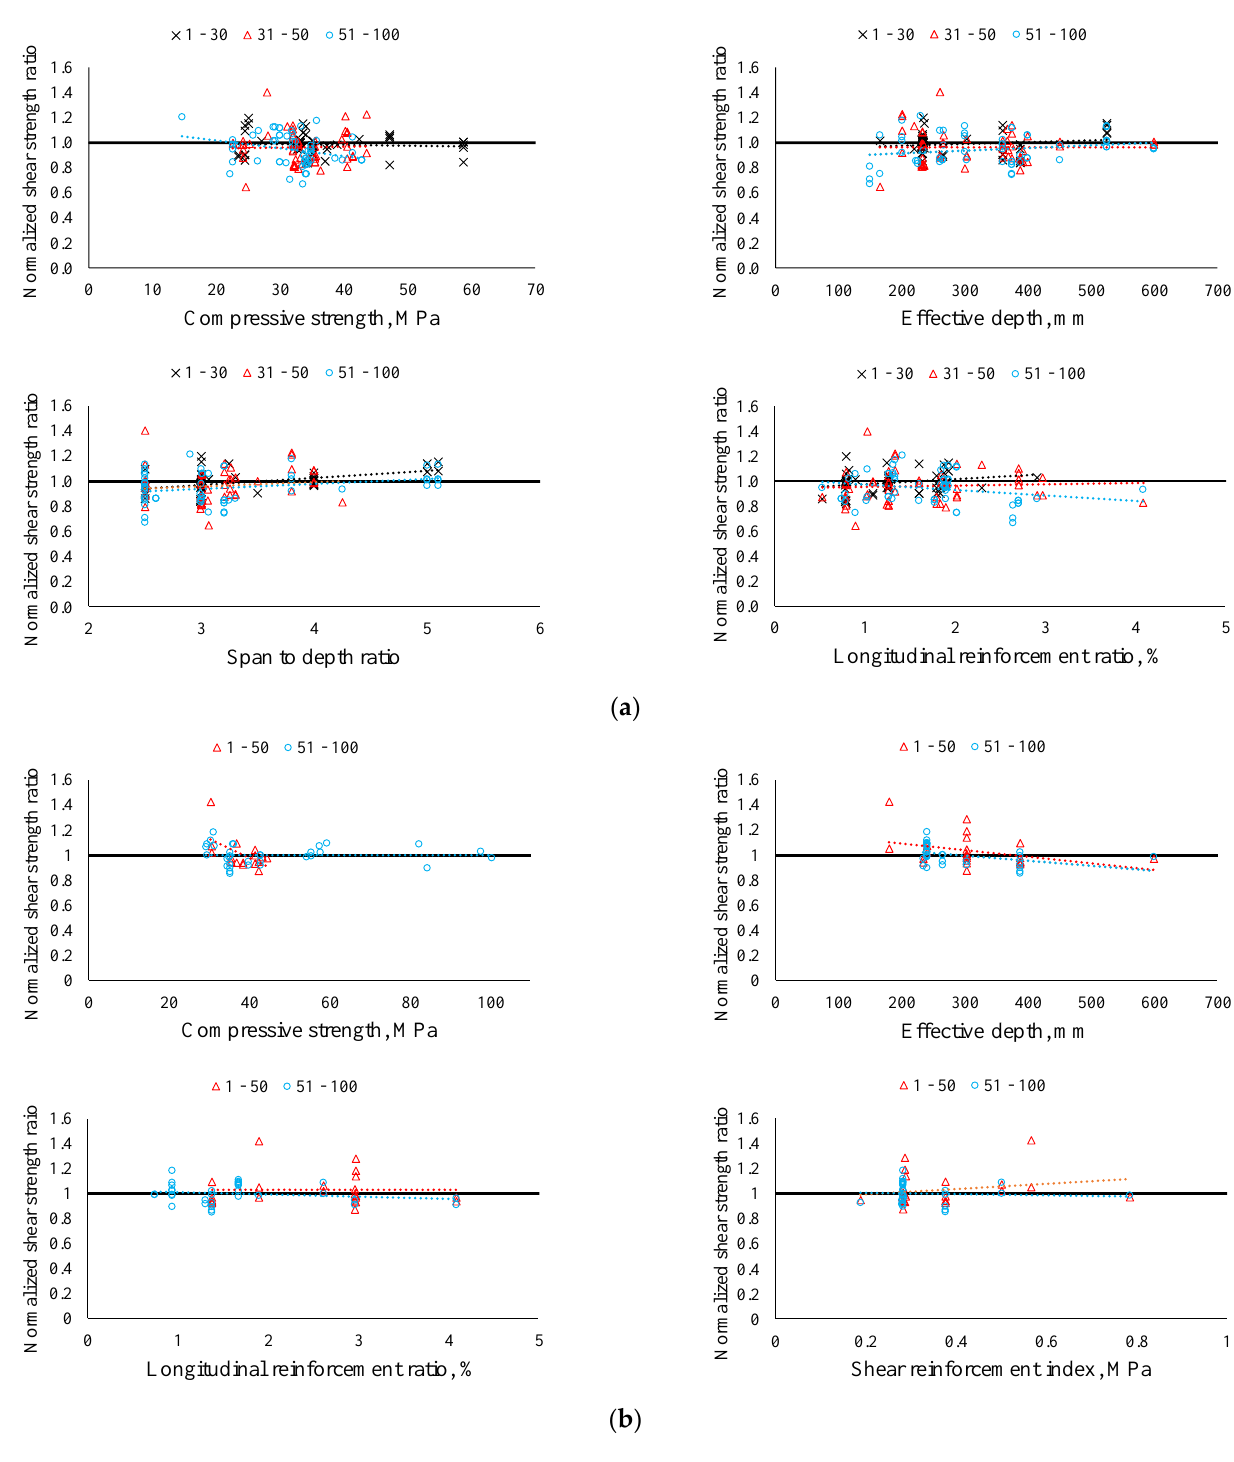
Figure 7. Normalized shear strength ratio against key influencing factors. ( a ) Specimens without shear reinforcement. ( b ) Specimens with shear reinforcement.